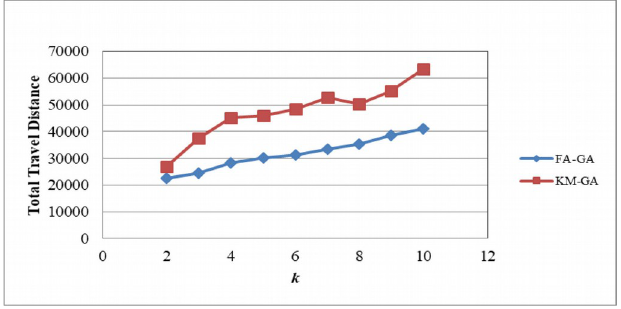
Figure A-3. Total traveling distance vs. k for instance